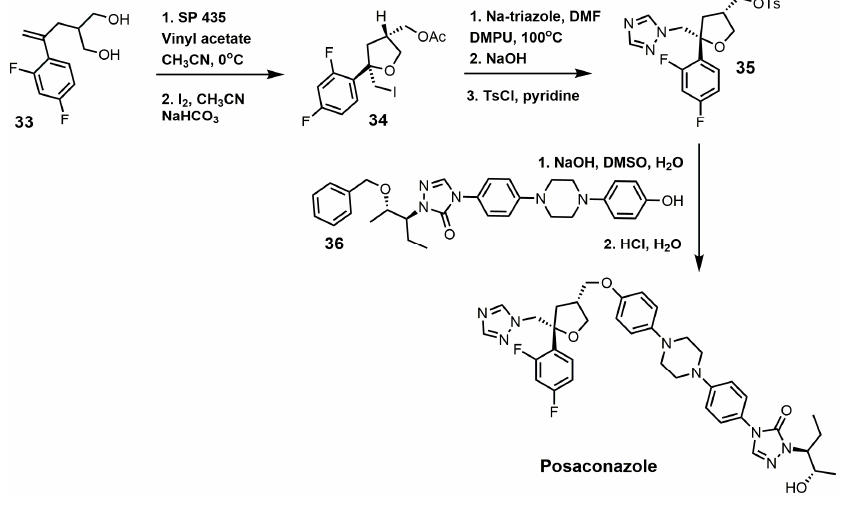
Figure 16. Synthesis of posaconazole.